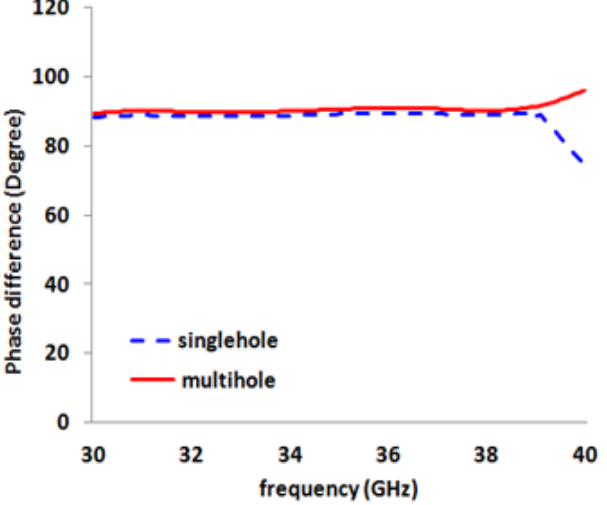
Figure 4. Simulated phase difference between output ports for both case study of the prototype coupler.